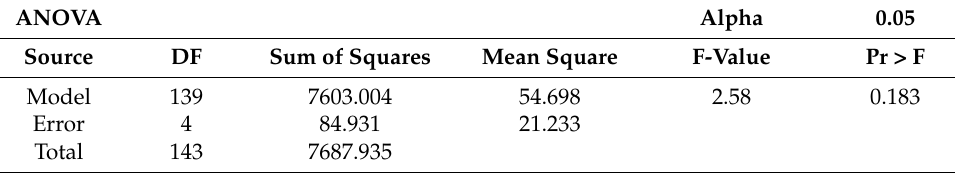
Table 9. ANOVA table for